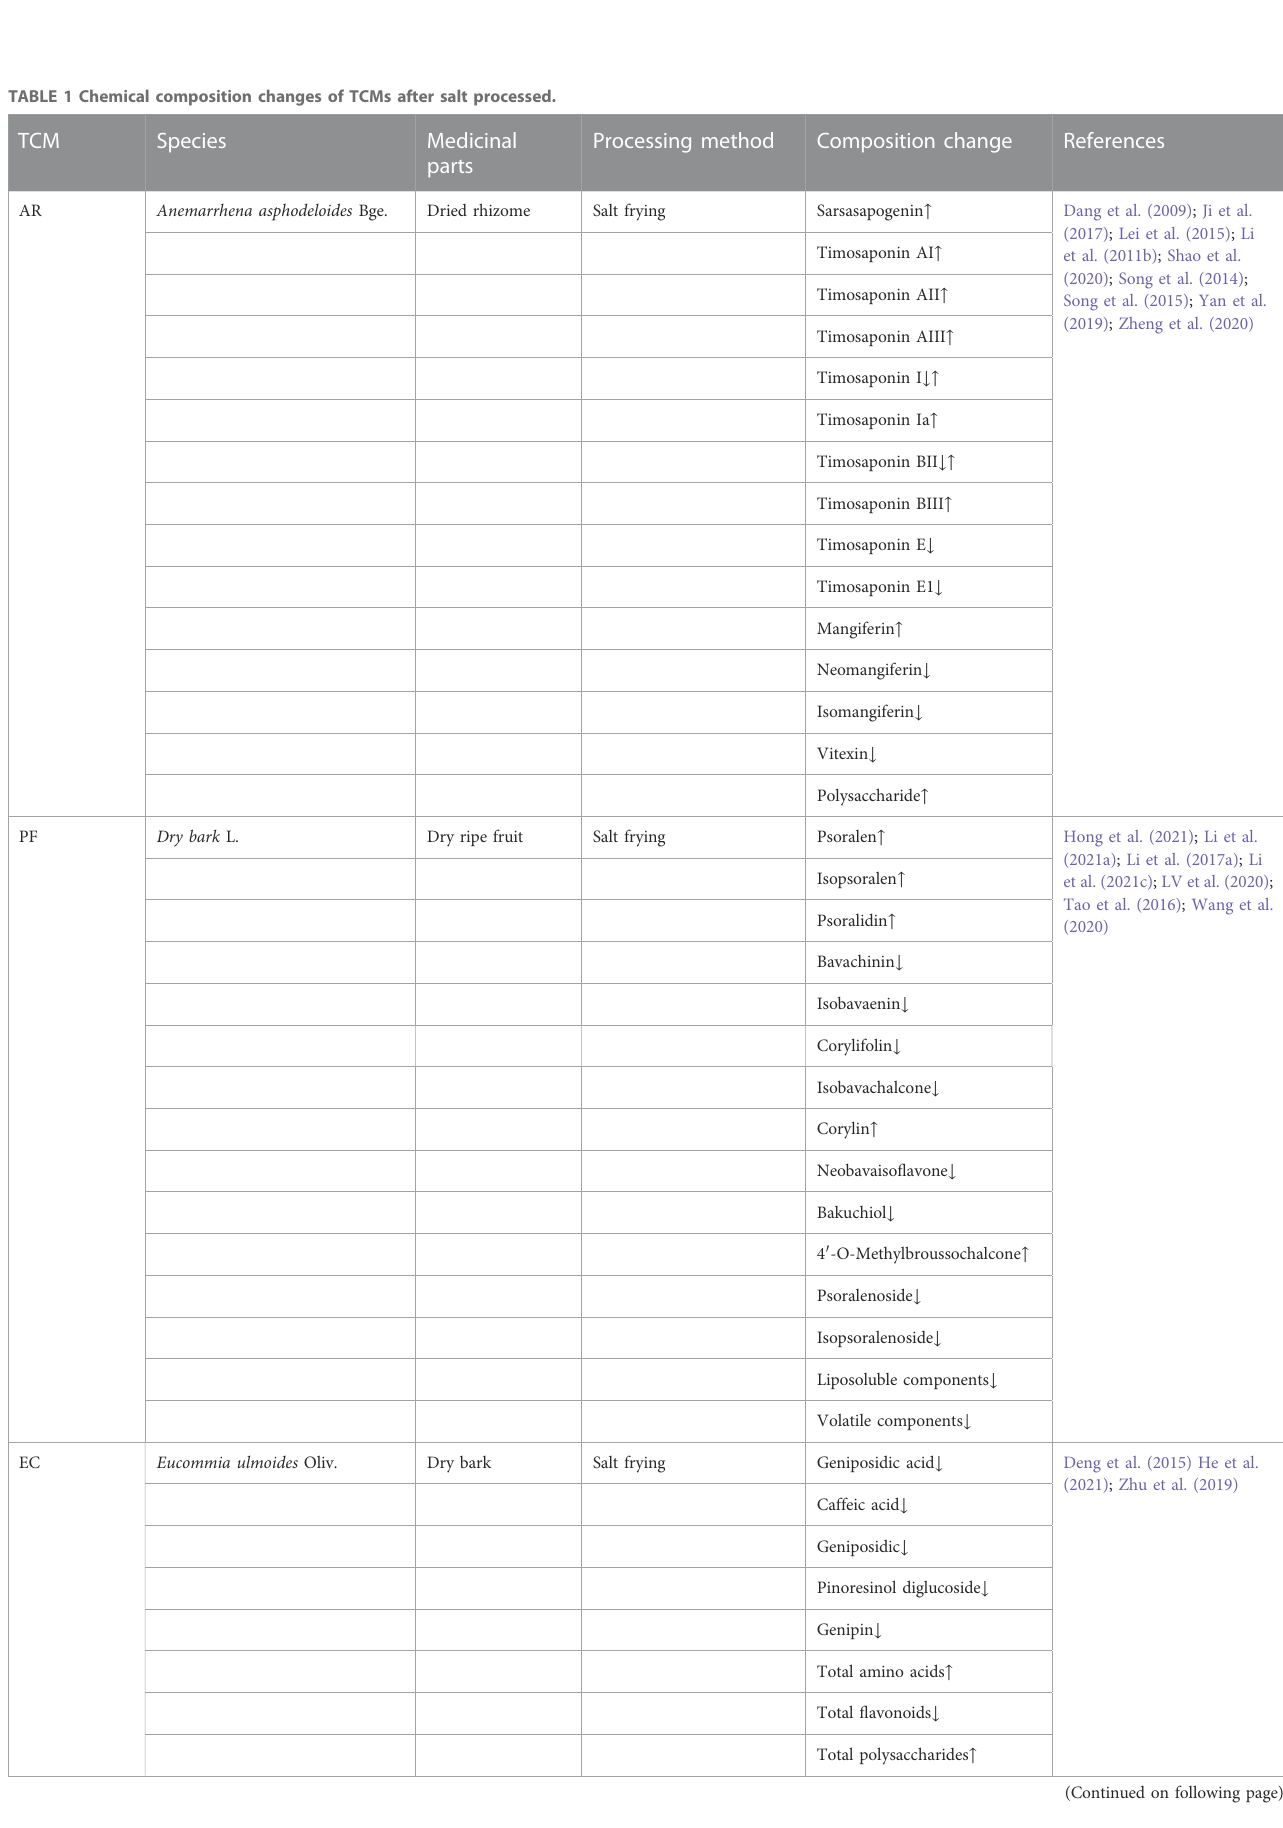
TABLE 1 Chemical composition changes of TCMs after salt processed.